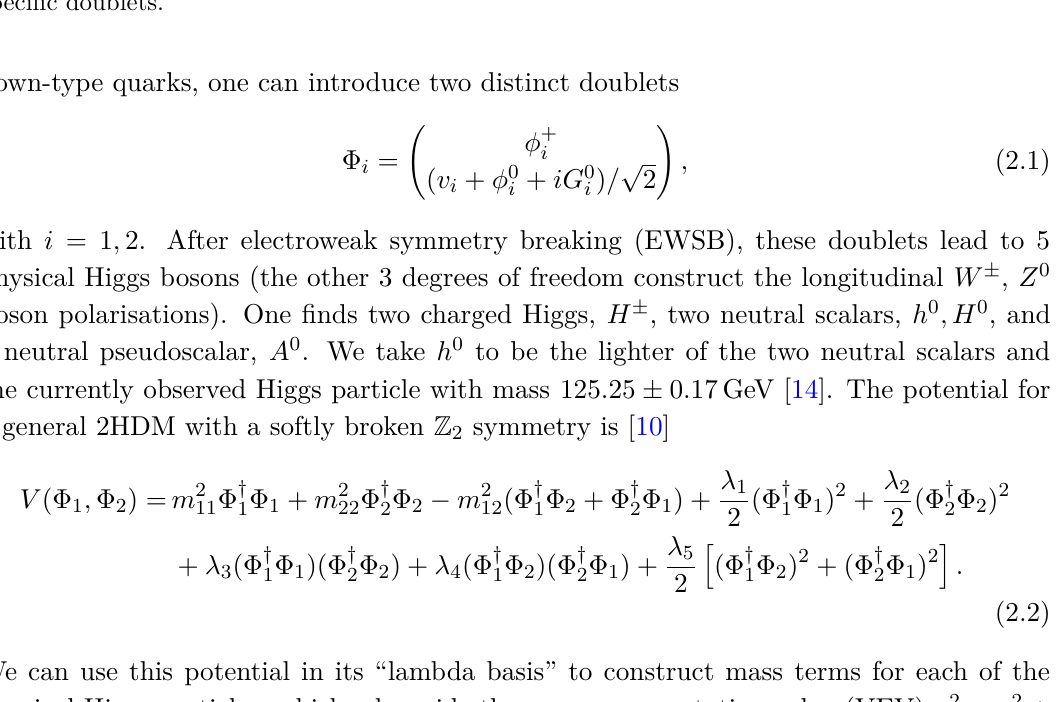
Table 1 . Types of 2HDM with natural flavour conservation from demanding fermions couple to specific